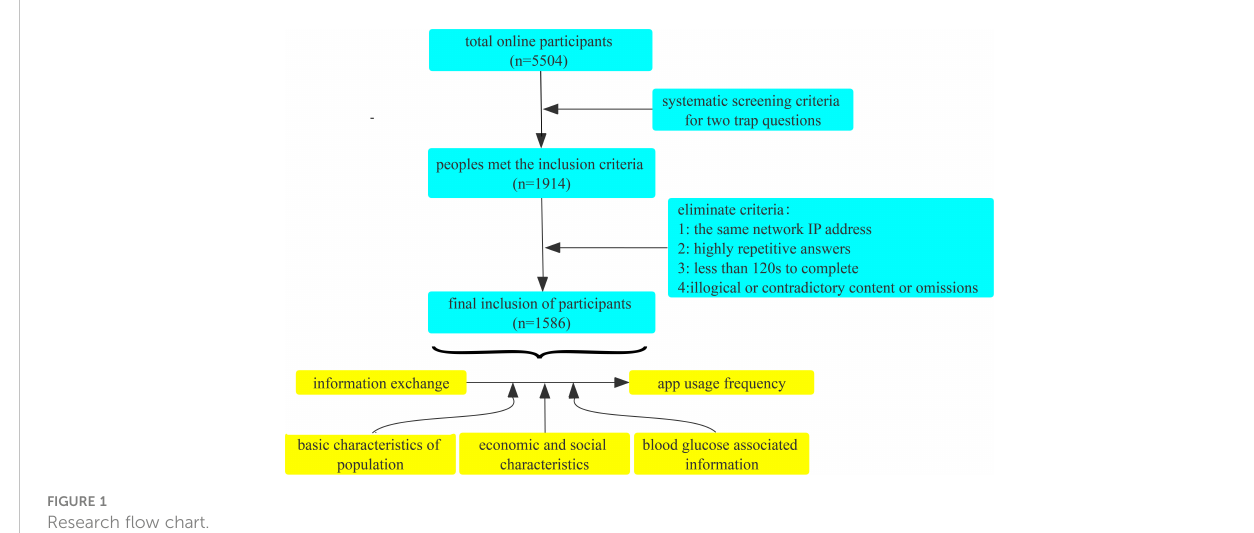
FIGURE 1 Research fl ow